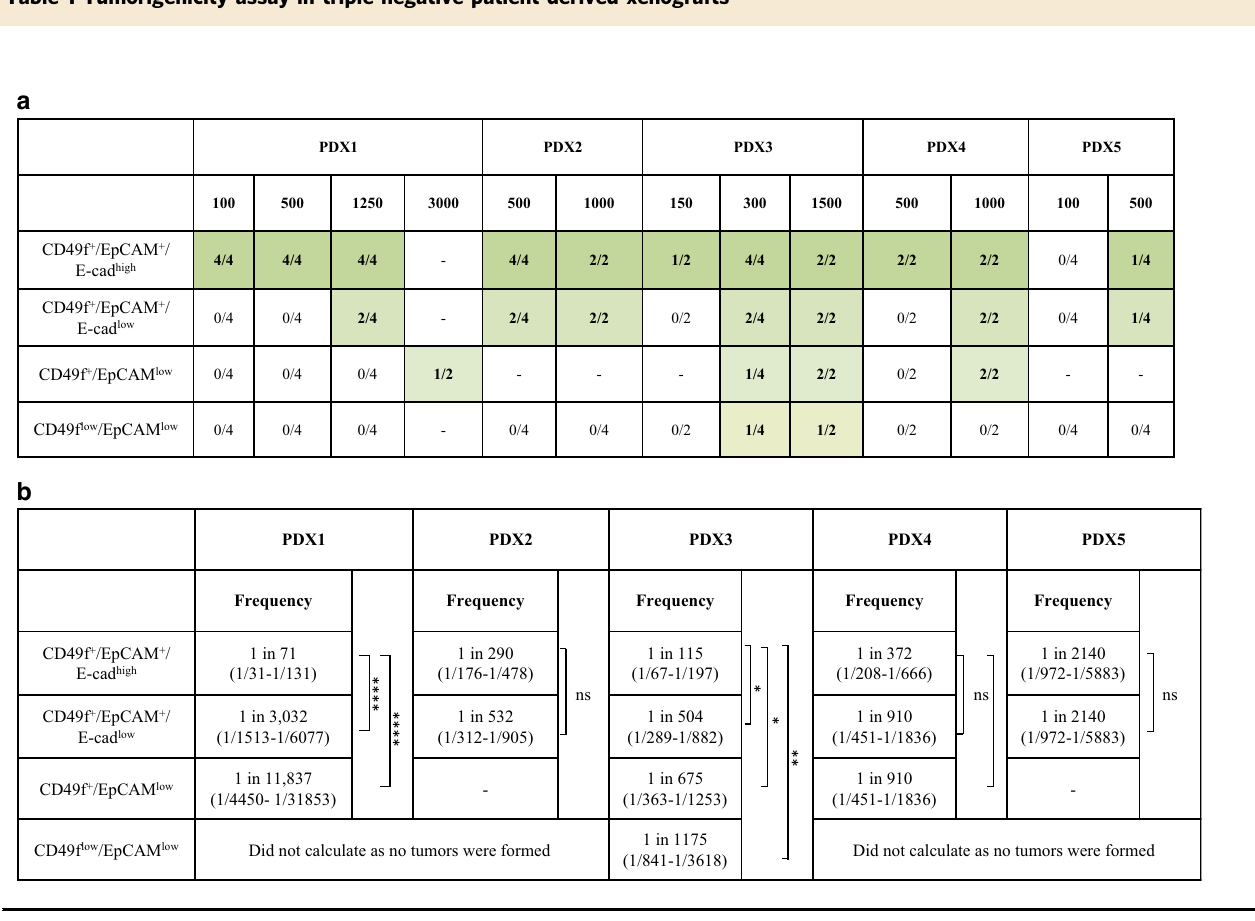
Table 1 Tumorigenicity assay in triple negative patient derived